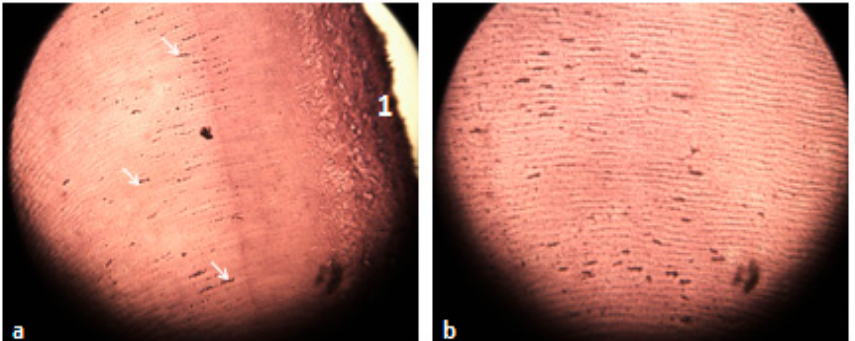
Figure 5. Histologic microphotographs of extracted teeth (root treated in two sessions with Cupral). The samples were processed, stained with H&E and cut in horizontal section. ( a ) The inner wall of the canal dentin has an intense impregnation with copper sulfite (1); also the penetration of copper crystals along the entire length of the dentinal tubules is observed (white arrows). ( b ) The extended penetration of copper crystals in the dentinal tubules is quite noticeable, thus ensuring permanent sterility. Representative images are shown in a magnification of 400 ×